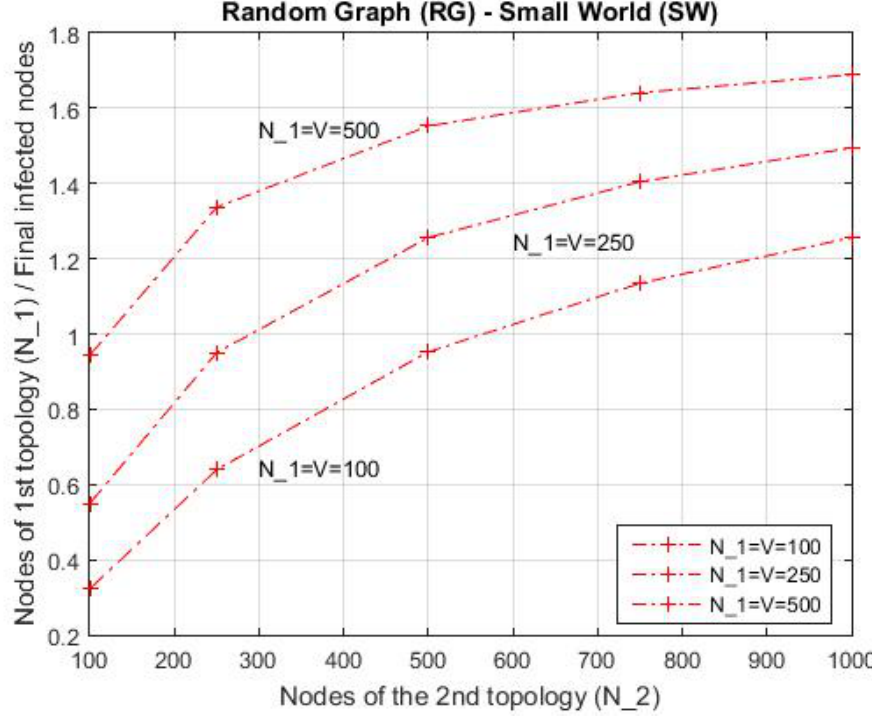
Figure 4. Random Graph and Small-World, while N_1 = 100, N_1 = 250 and N_1 = 500.